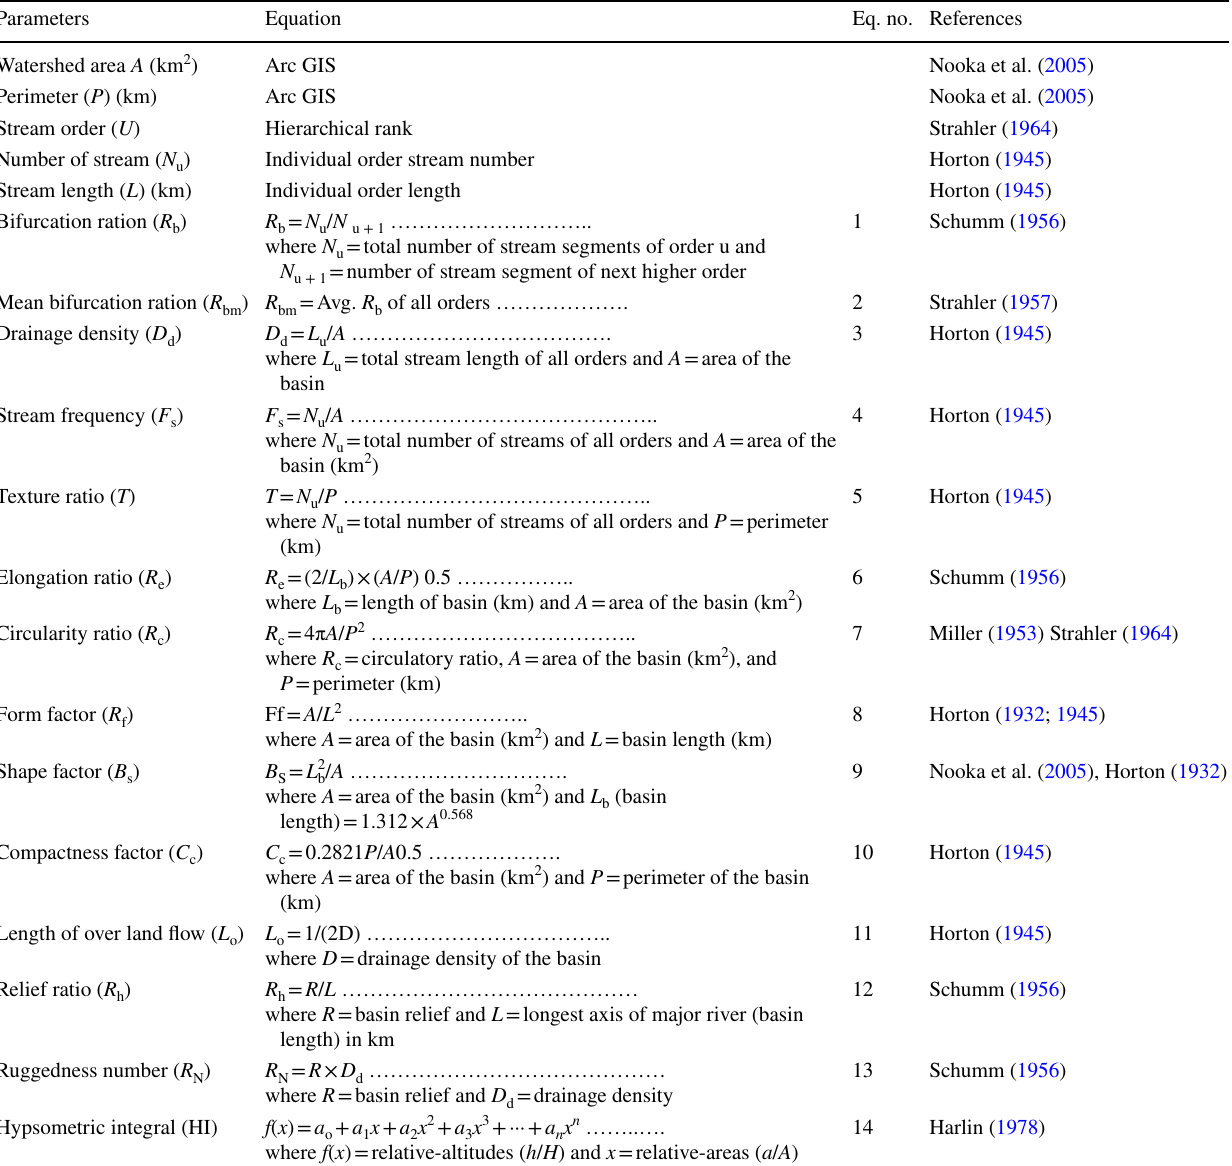
Table 2 Calculation of morphometric parameter for all watersheds Parameters